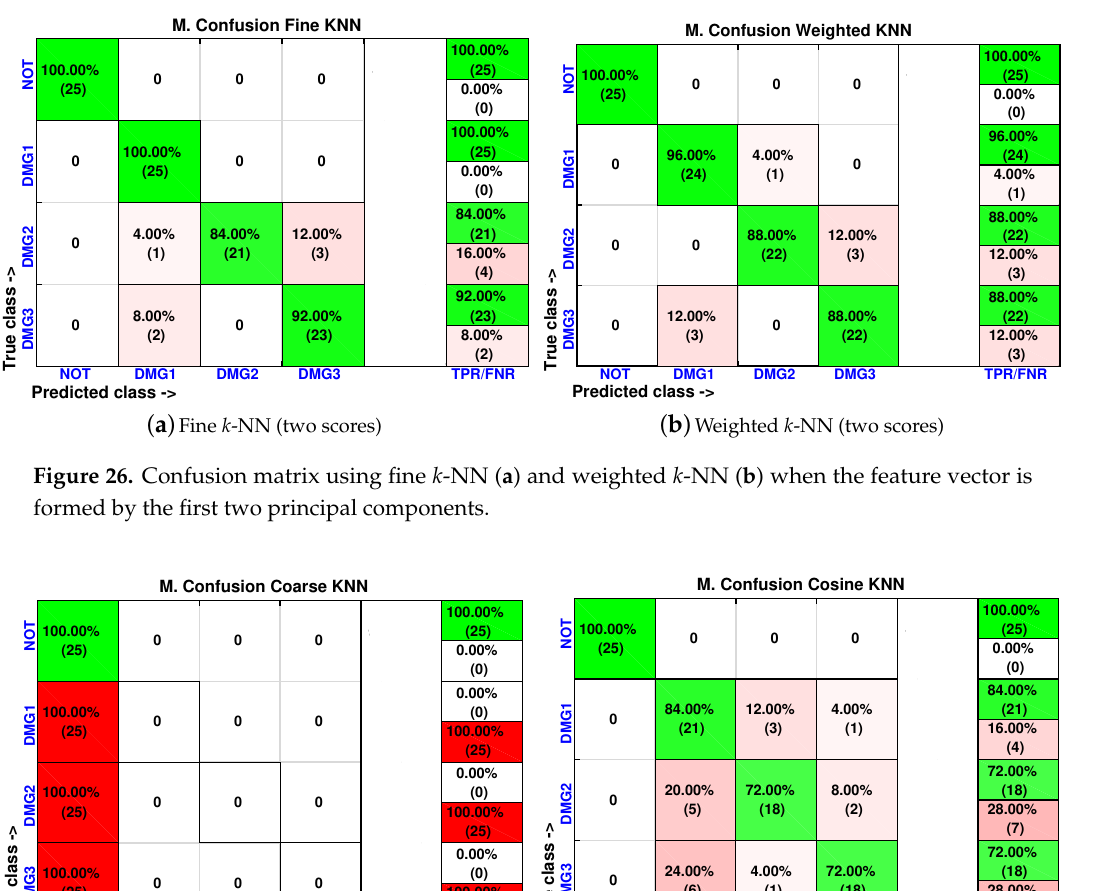
Figure 25. Cumulative contribution rate of variance accounting for the principal components from the data acquired from the aluminum plate.